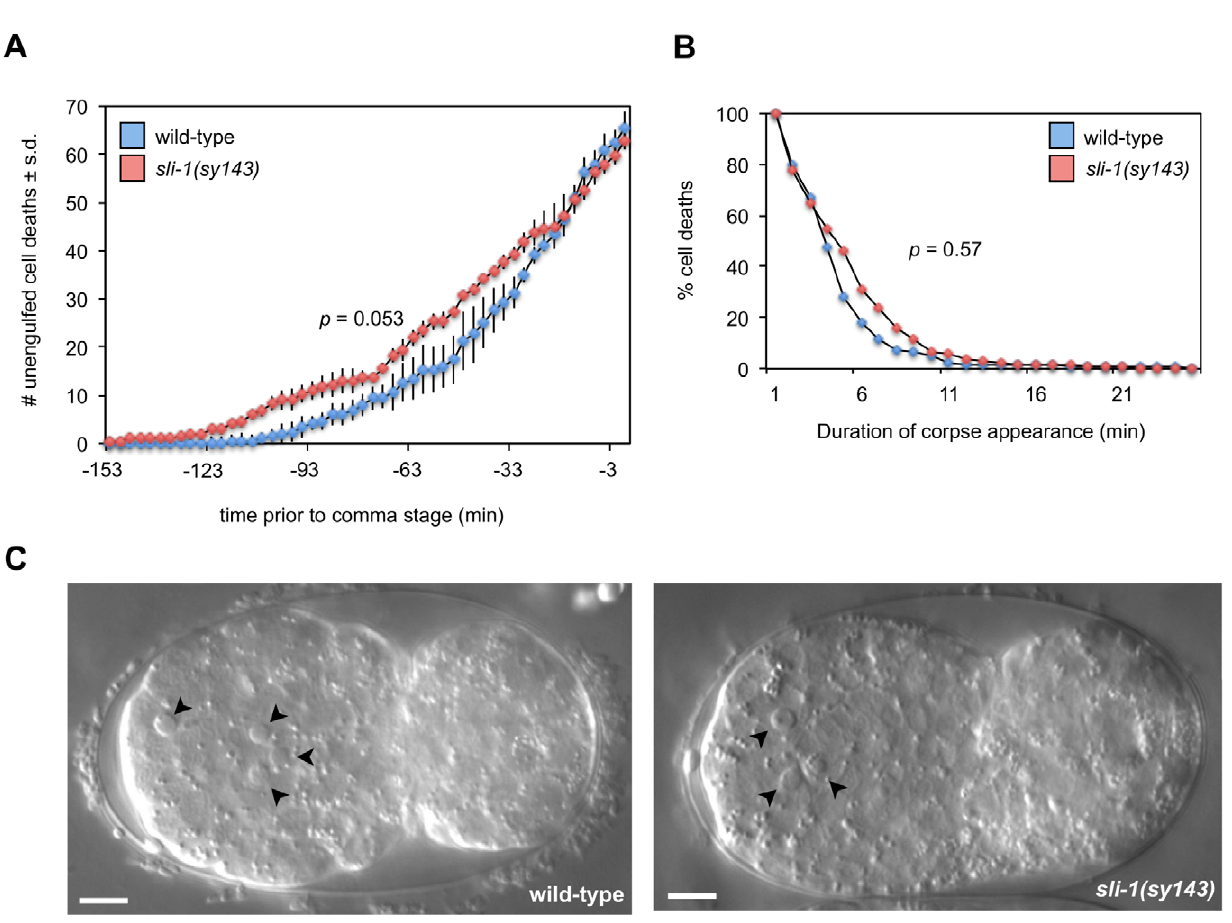
Table 2. sli-1 mutation and programmed cell death.